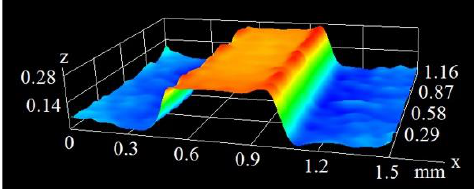
Figure 4. Image of a microfin from a pulse duration of 60 ns and velocity of 400 mm/s. The temperature at the heater surface (on which the laser-textured samples are sol-